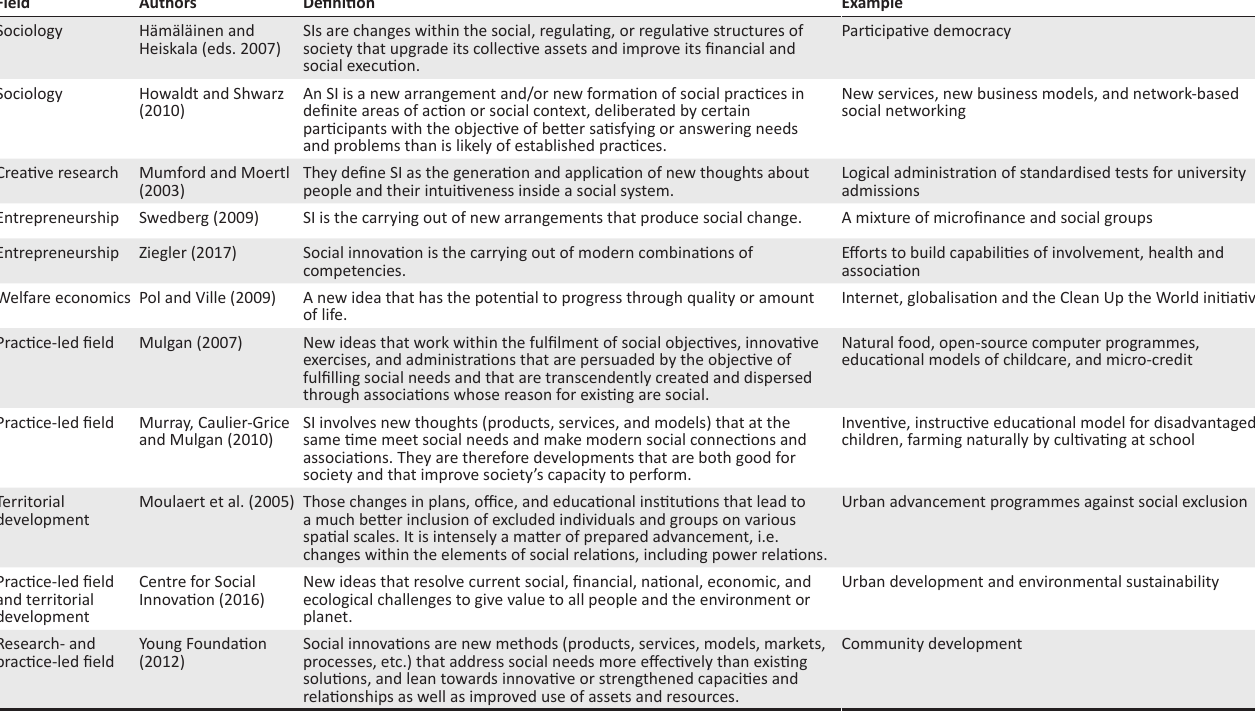
TABLE 1 : Conceptualising social